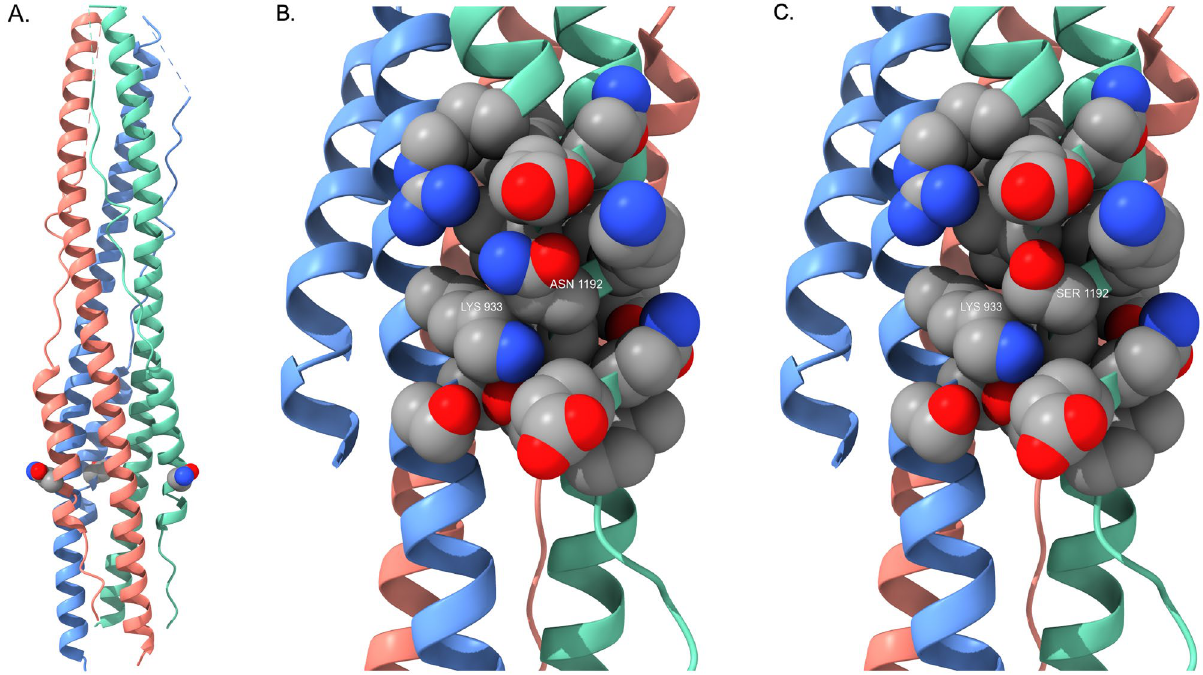
Figure 7. ( A ) Post-fusion six-helix bundle (PDB ID: 6LXT) illustrating the location of the N1192S mutation. S1192 is rendered as a CPK residue (one per receptor monomer) and color-coded by atom type as described in Fig. 5. ( B ) Detailed view of side chain packing interactions formed by N1192. K933 is from the neighboring monomer; this image illustrates the tight packing contacts formed by proximate side chains that stabilize the six- helix bundle fusion structure. C) Detailed view of side chain packing interactions formed by the S1192 mutant. The helix bundle orientation is identical to that in Fig.